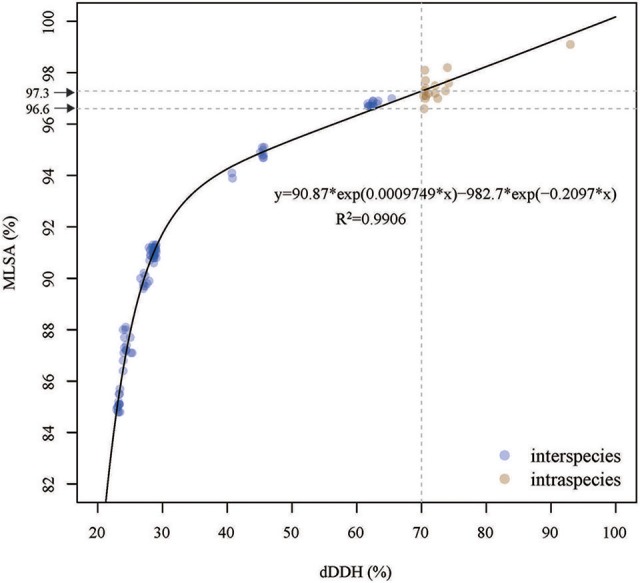
The Correlation analysis between the dDDH values and MLST similarities for resprestative Thicolava strains. The vertical line indicates the 70% dDDH threshold. The horizontal line (y = 97.3) indicates the estimated MLSA similarity threshold corresponding to 70% dDDH threshold.